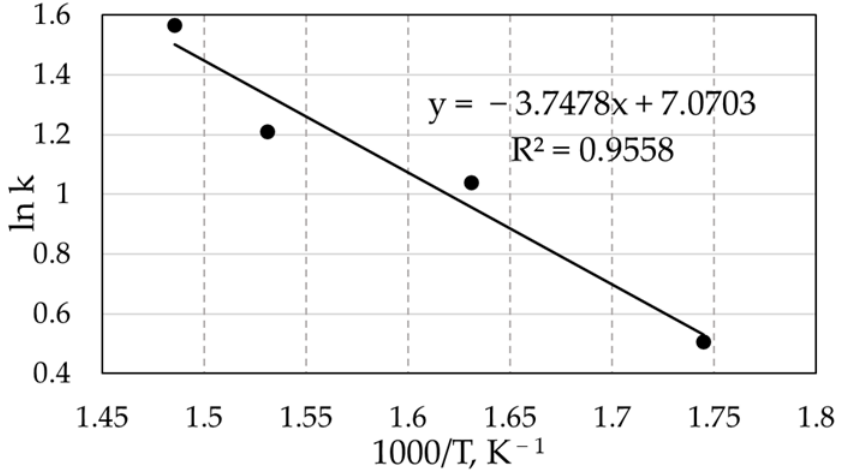
Figure 2. Dependence of the logarithm of the rate constant of the hydrodesulfurization reaction of the diesel fraction on the reciprocal absolute temperature (ln k = − 3747.8